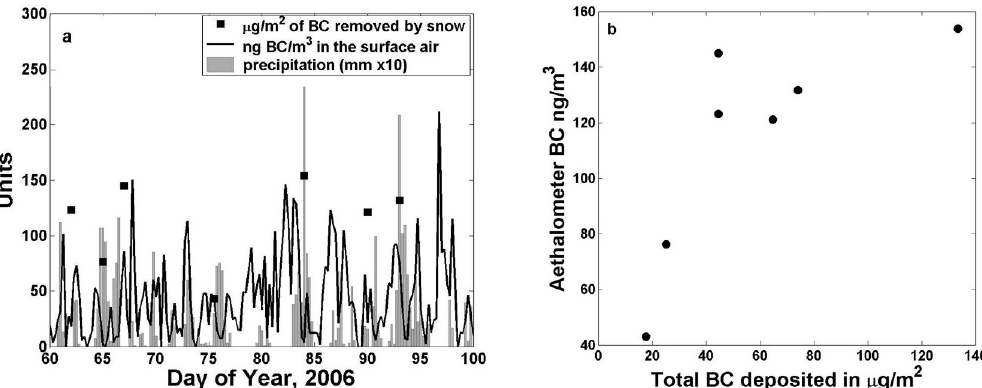
Fig. 3. (a) BC/m 3 in the surface air (black line), mm of snow depth accumulated in 6h increments (light grey bars), total BC µg/m 2 (units converted from ng/cm 2 to fit on figure) deposited by the falling snow during a 24 to 48h period depending on timing of the snowfall (black squares). (b) Correlation of BC removed in a precipitation event to average ambient concentrations during the 6h prior to the event. R 2 = 0 . 56. Data are from LAVO.